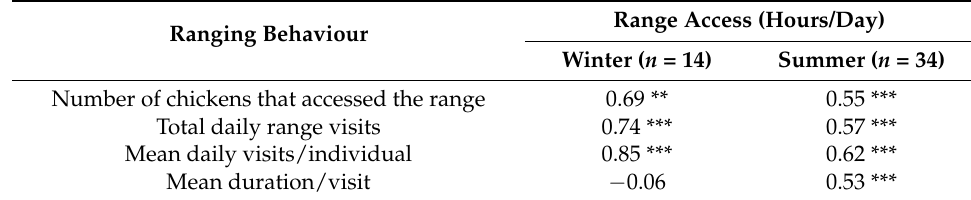
Table 2. Pearson′s partial correlation coefficients ( r ), controlling for flock and age, between the number hours the range was available each day and ranging behaviour for winter and summer flocks. Range Access (Hours/Day) Ranging Behaviour Winter ( n = 14) Summer ( n = 34) Number of chickens that accessed the range 0.69 ** 0.55 *** Total daily range visits 0.74 *** 0.57 *** Mean daily visits/individual 0.85 *** 0.62 *** Mean duration/visit − 0.06 0.53 *** Note: ** and *** indicates significance at the 0.01 and 0.001 level respectively.